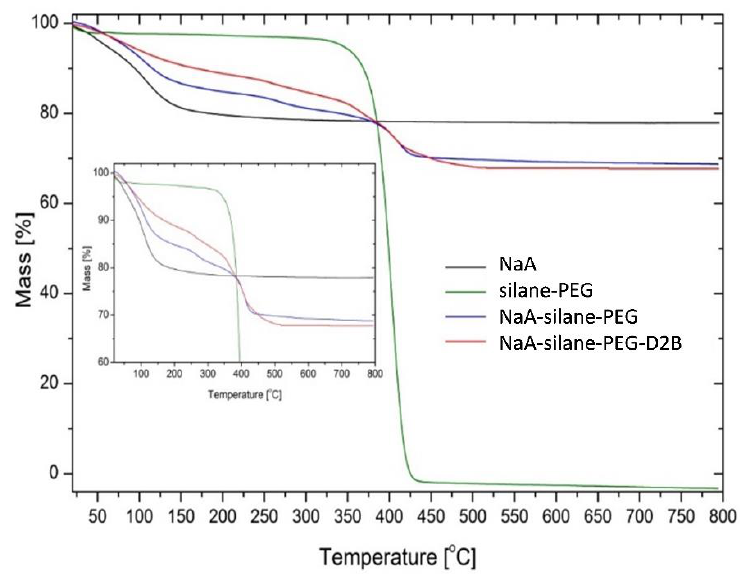
Figure 5. Representative thermograms of NaA nanozeolite (NaA), silane-PEG molecules (silane-PEG), NaA nanozeolite functionalized with silane-PEG (NaA-silane-PEG), and NaA nanozeolite functionalized with silane-PEG and D2B antibody (NaA-silane-PEG-D2B). Inset shows the values of mass from 60%–100%.